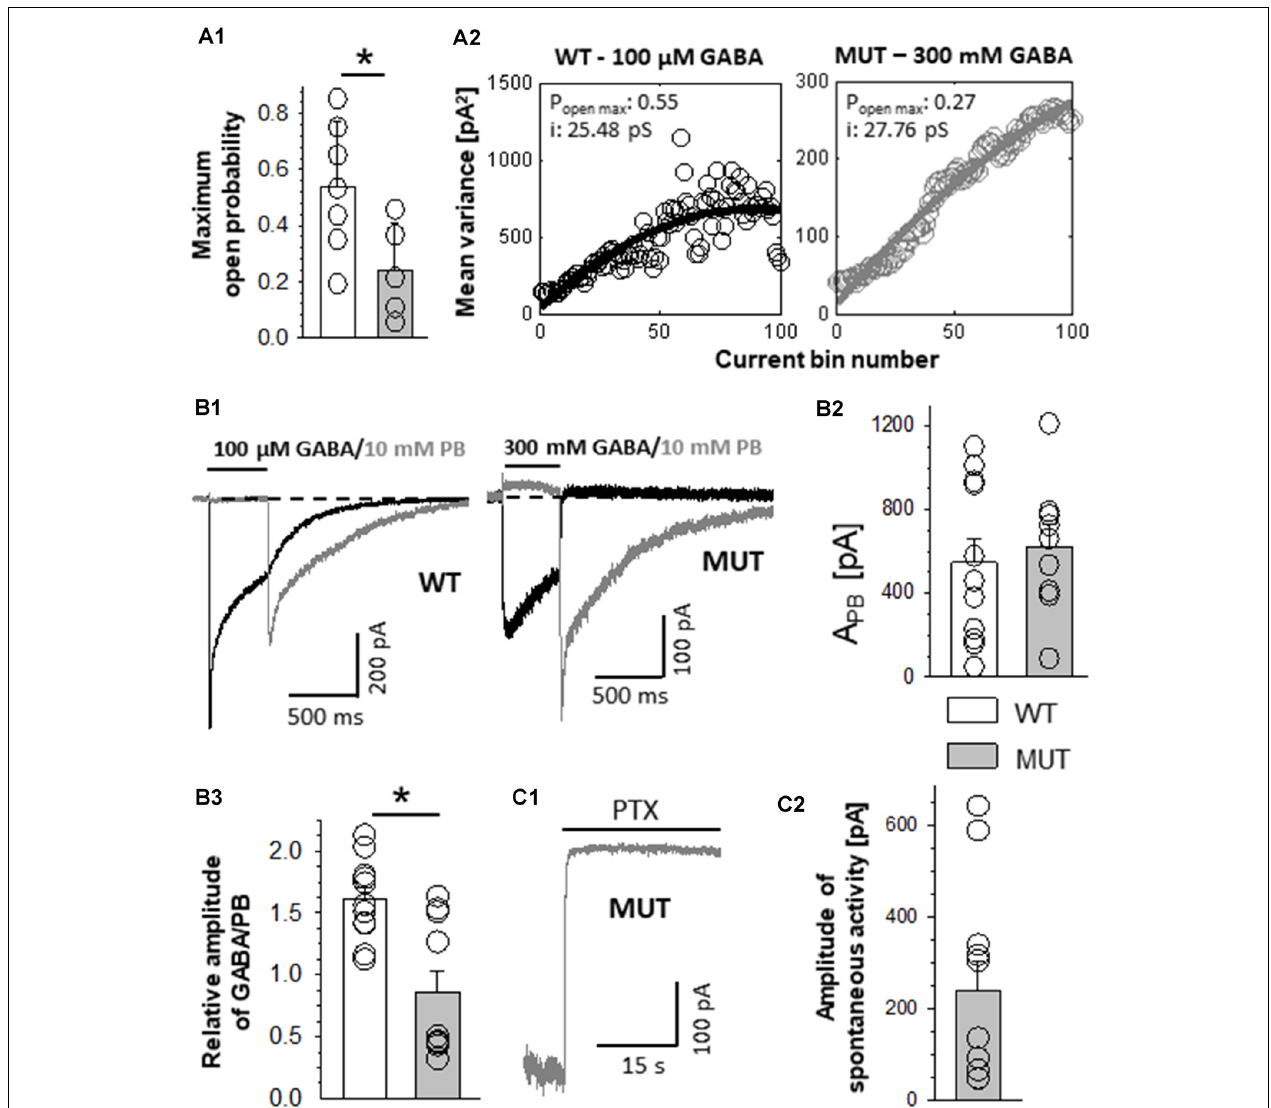
FIGURE 2 | The impact of β 2 E155C mutation on the maximum open probability and the level of spontaneous activity. (A1) Statistics of the maximum open probability determined using nonstationary variance analysis (NSVA). (A2) Plots that represent the variance of the current at each time point. (B) Results of experiments in which high (GABA) or 10 mM PB was used. (B1) Left, typical traces of current responses evoked by 100 µ M GABA (black line) and rebound current observed upon removal of 10 mM PB (gray line) mediated by wild-type (WT) receptors. (B1) Right, currents mediated by the mutants (MUT) and evoked by 300 mM GABA and tail currents following wash-out of 10 mM PB. Insets above traces indicate agonist applications. Baseline level is drawn with a dashed line. Note that in the case of mutation, a larger block appearing during PB application is seen, which indicates a larger extent of spontaneous current mediated by the MUT than in